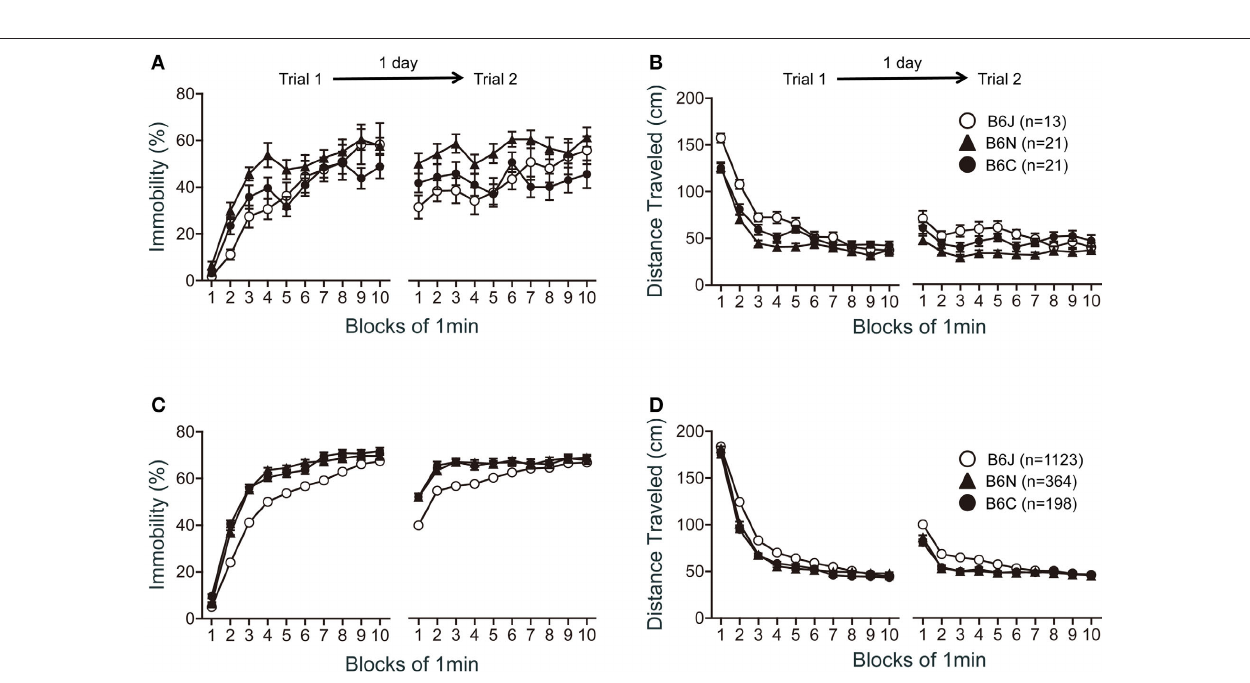
Figure 7 | Startle response/prepulse inhibition test of C57BL/6 substrains. (A,B) Regular scale analysis. (C,D) Large-scale analysis. (A,C) Acoustic startle response for the 110 and 120 dB startle stimulus. C57BL/6N showed the lowest